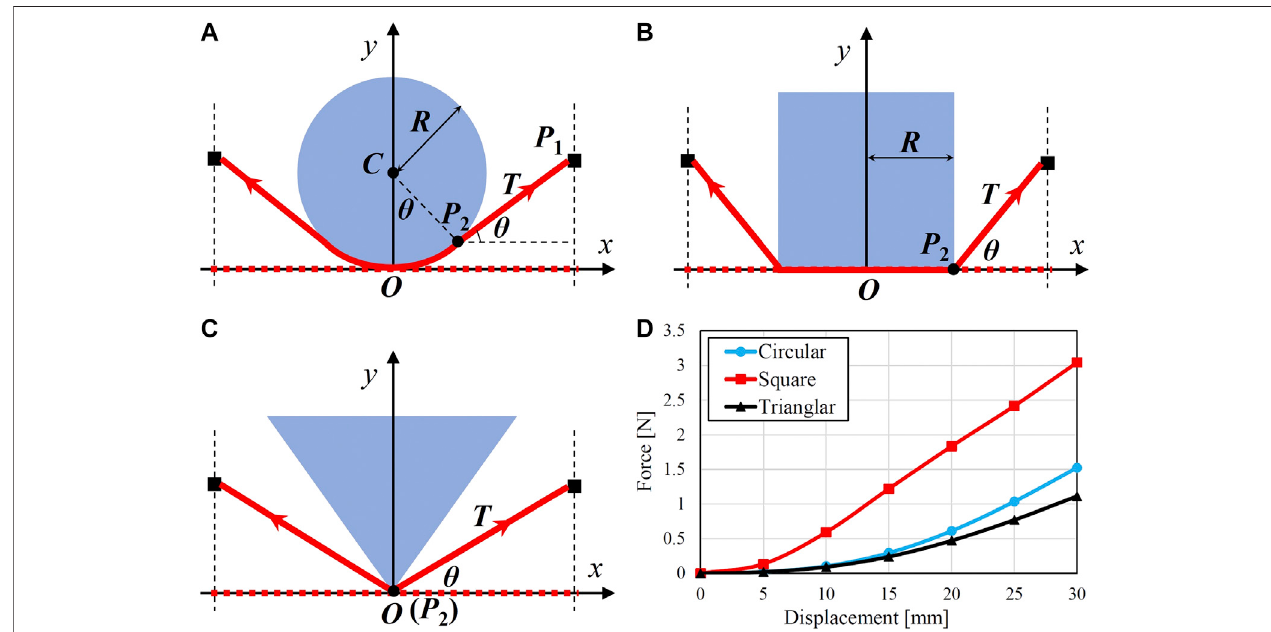
FIGURE 7 | Model diagram for calculating the binding force while grasping a (A) circular, (B) square, and (C) triangular object, respectively. (D) depicts the calculated binding forces against different binding displacements.